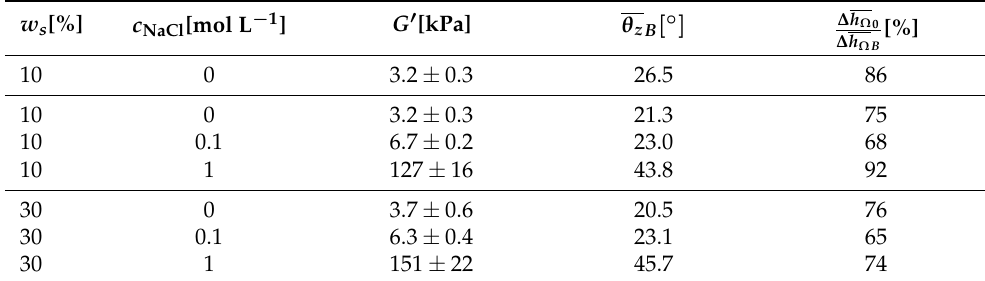
Table 3. Sample parameters, the mean particle z -angle θ zB at B = 380mT and the ratio of the initial and the lasting change of the solid angle as calculated by Table